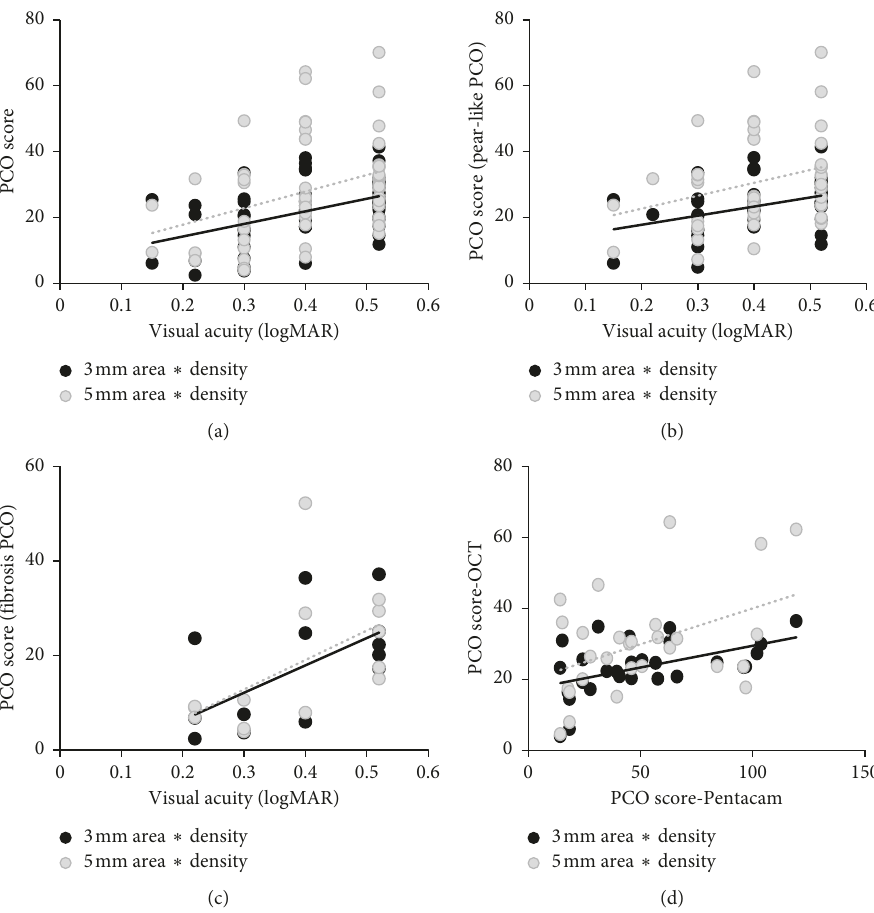
Figure 5: Relationship between visual acuity and PCO scores at the 3mm and 5mm IOL optic regions. Spearman’s correlation analysis was used. (a) Visual acuity and PCO scores for all PCO ( r � 0 . 43, p ≤ 0 . 001; r � 0 . 38, p ≤ 0 . 001); (b) visual acuity and PCO scores for pear-type PCOs ( r � 0 . 36, p � 0 . 01; r � 0 . 29, p � 0 . 05); (c) visual acuity and PCO scores for fibrosis-type PCOs ( r � 0 . 56, p � 0 . 04; r � 0 . 67, p � 0 . 01); (d) PCO scores with OCTand PCO scores with the Pentacam ( r � 0 . 41, p � 0 . 03; r � 0 . 22, p � 0 . 24). PCO score � PCO area × (PCO density − light scatter